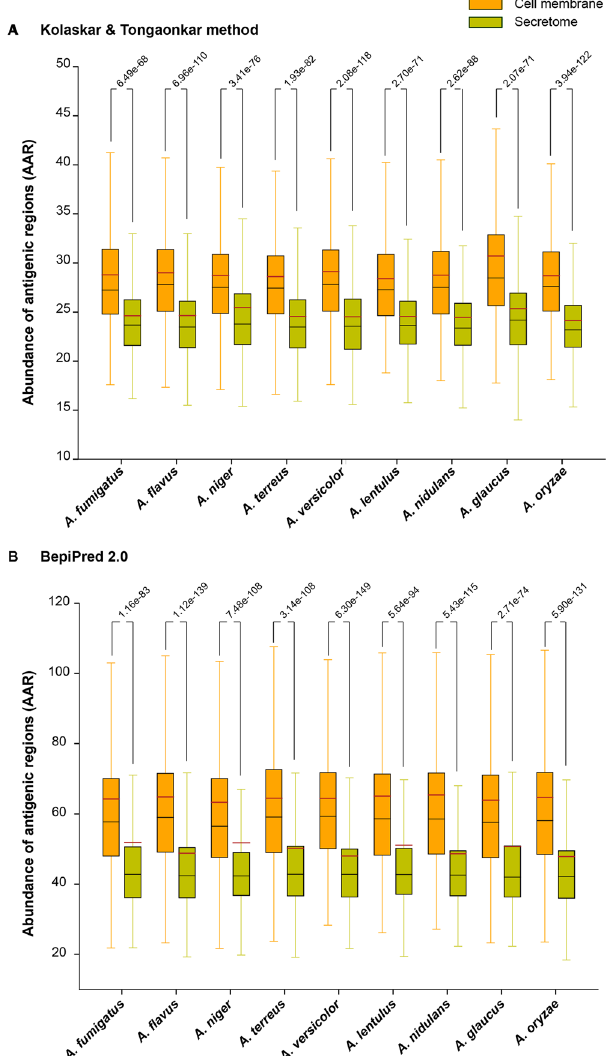
Figure 6. Distribution of Abundance of Antigenic Regions (AAR) values for the set of cell membrane proteins and secreted extracellular proteins in Aspergillus species considered here. AAR values were computed using two different methods: ( A ) Kolaskar-Tongaonkar 106 method and ( B ) BepiPred 2.0 107 . In each box plot, the lower end of the box represents the first quartile, black line inside the box is the median, brown line is the mean and the upper end of the box represents the third quartile of the distribution. In this figure, we also report the p - value from the comparison of the distributions of AAR values in the set of cell membrane proteins and in the set of secreted proteins for each Aspergillus species performed using Wilcoxon rank-sum